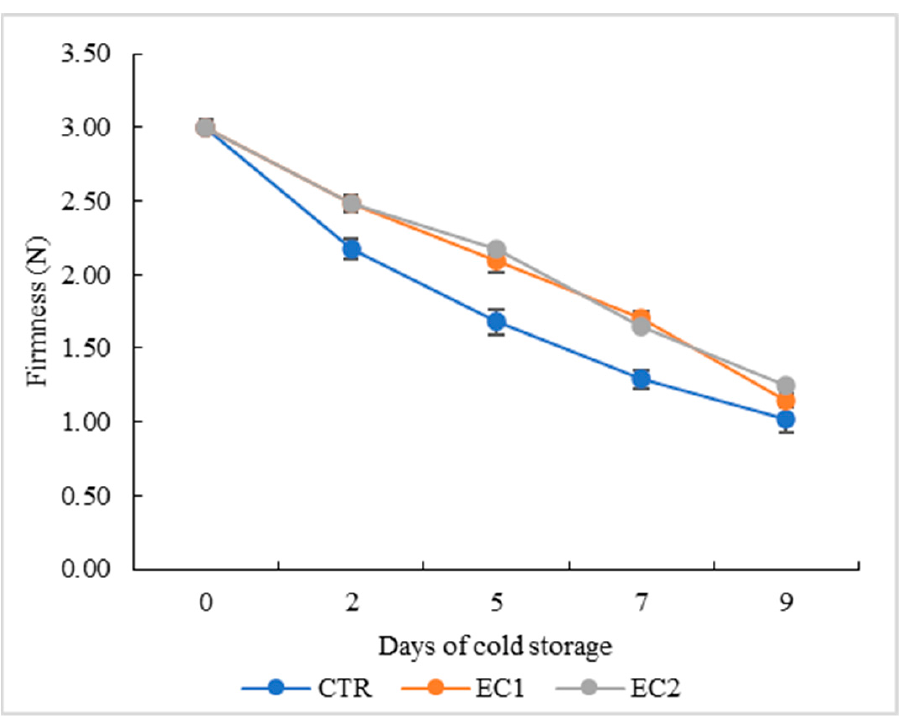
Figure 2. Variation in firmness (F—N) measured during 9 days of cold storage. Data correspond to the mean and bars indicate the standard deviation (SD) of three replicates (n = 3).